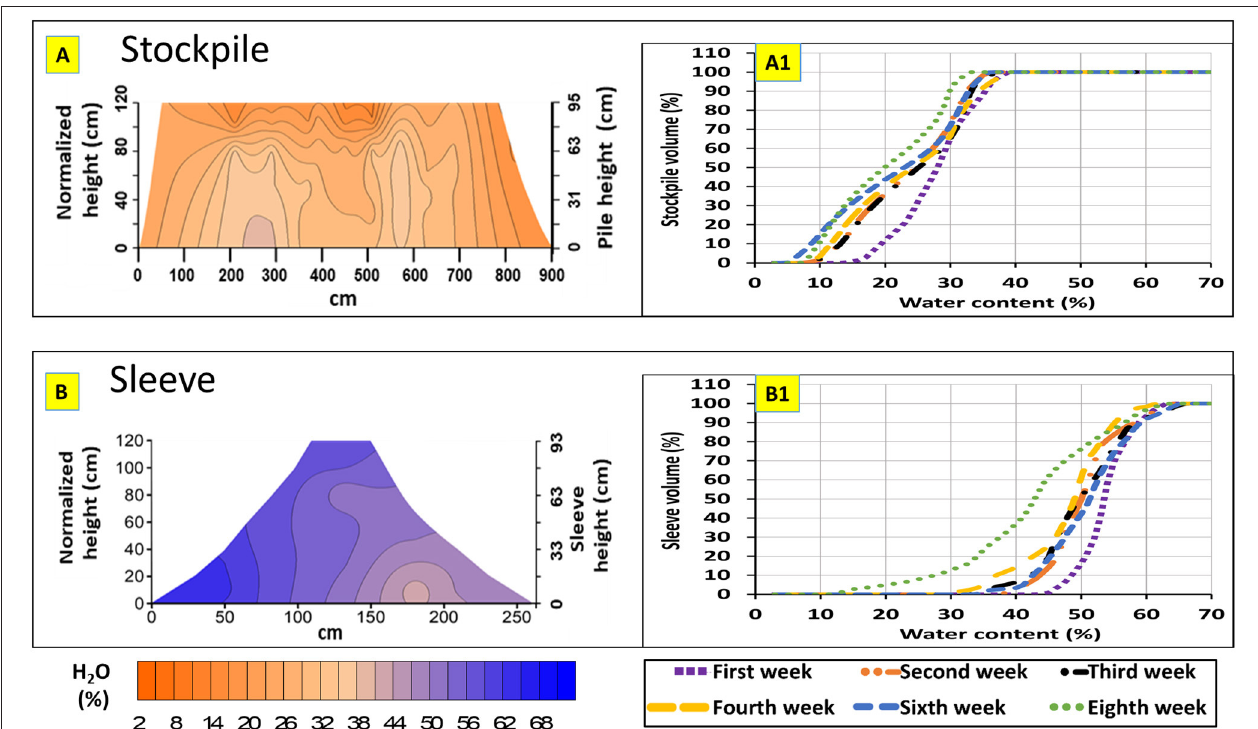
FIGURE 3 | Spatial–temporal variation of water content (%). Contour maps (week 1) and the cumulative volumetric percentage of water content in the stockpile (A,A1) and the sleeve ( B ; cross-section II, B1 ; weighted average of cross-sections I–IV).